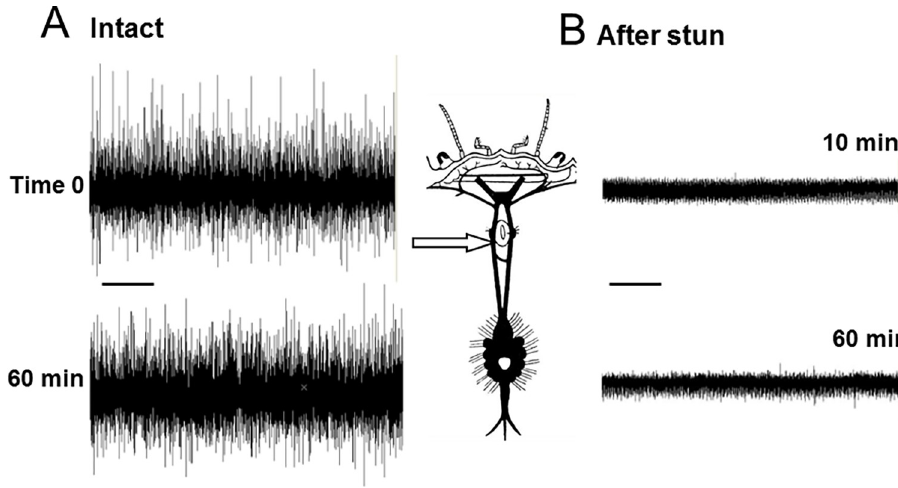
Fig 5. Time course of CNS activity with and without electrical stunning. Spontaneous nerve activity recorded extracellularly in the left circumoesophageal connective of C . pagurus . A: activity in intact animal initially and after 60 min; B: activity in another crab at 10 min and 60 min after electrical stunning. Scale bar